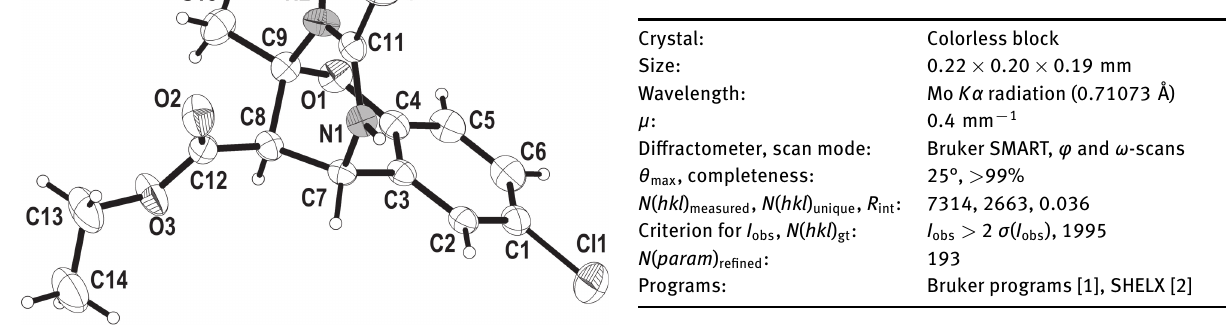
Table 1: Data collection and